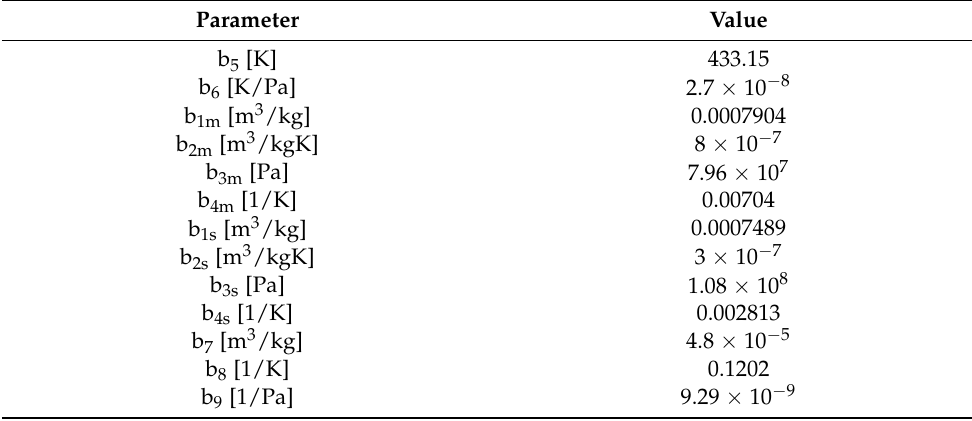
Table 2. The Tait parameters of the K30 biocomposite